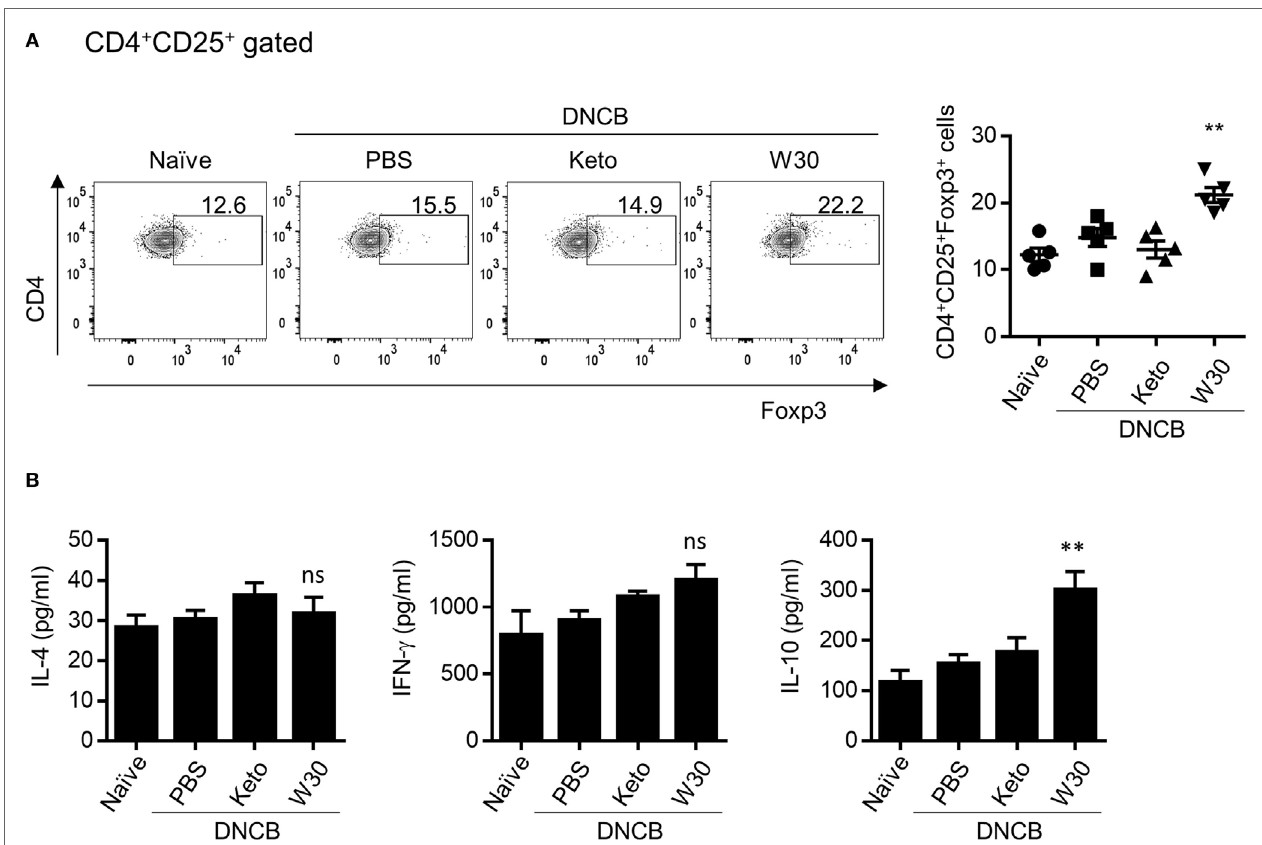
FigUre 4 | Modulatory effect of WIKIM30 on regulatory T cell (Treg)-related responses in mesenteric lymph nodes (MLNs) of atopic dermatitis (AD) mice. (a) Proportion of Tregs in MLNs. Isolated MLN cells were stained with antibodies against CD3, CD4, CD25, and Foxp3 and then analyzed by flow cytometry. (B) MLN cells were treated with anti-CD3/CD28 monoclonal antibodies for 48 h, and interleukin (IL)-4, IL-10, and IFN- γ levels in the culture supernatant were measured with the cytometric bead array kit. Data represent the mean ± SE of n = 5 mice per group from three independent experiments. Student’s t -test (unpaired); ** p < 0.01 vs. AD group. ns, p > 0.05 vs. AD